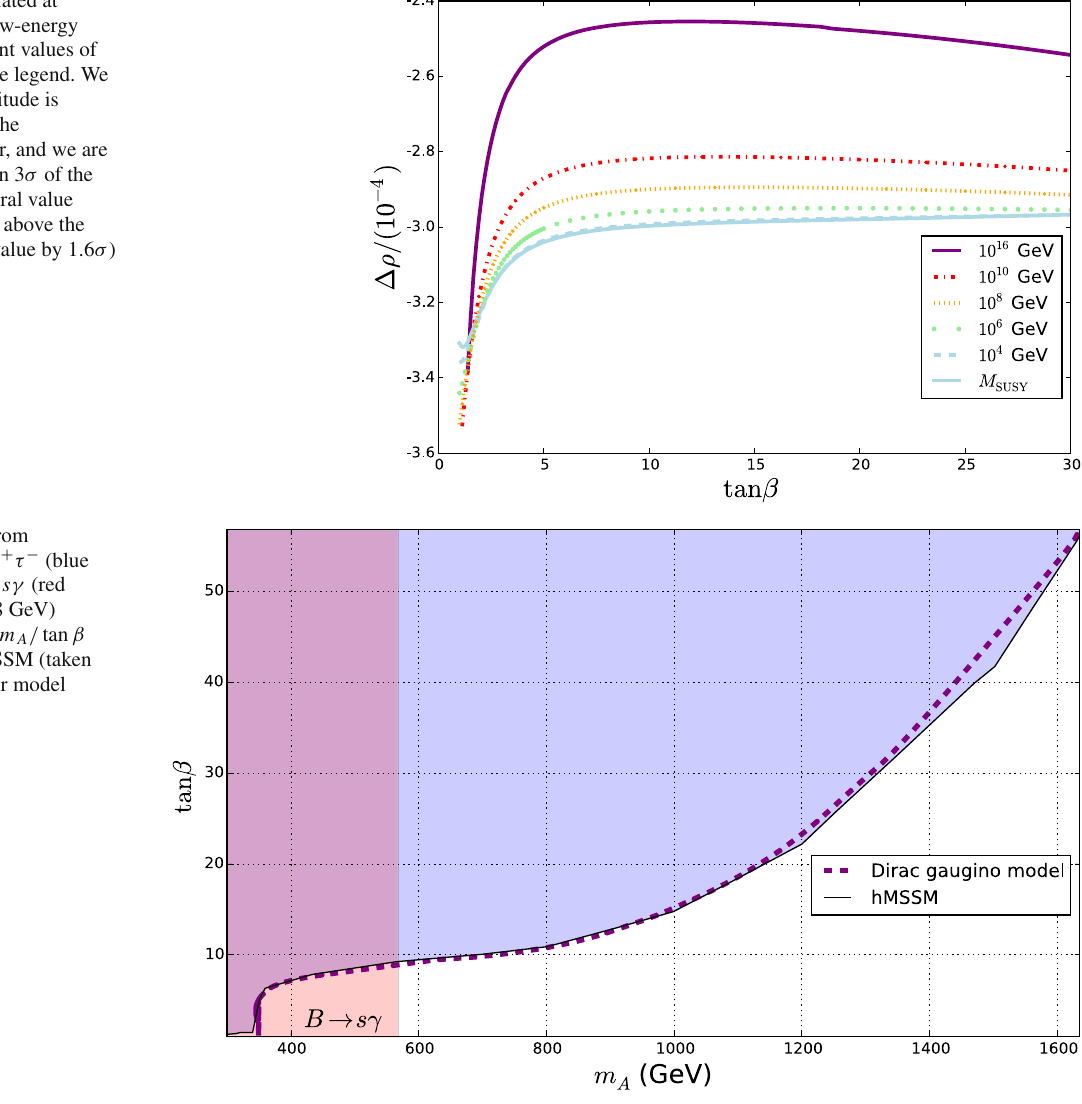
Fig. 7 (cid:17)ρ calculated at one-loop in the low-energy theory, for different values of M N = 2 given in the legend. We see that the magnitude is roughly equal to the experimental error, and we are always well within 3 σ of the experimental central value (which is anyway above the Standard Model value by 1 . 6 σ )